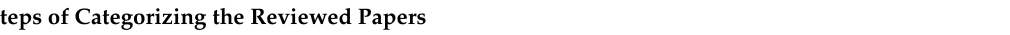
Table 5. Steps of the Systematic